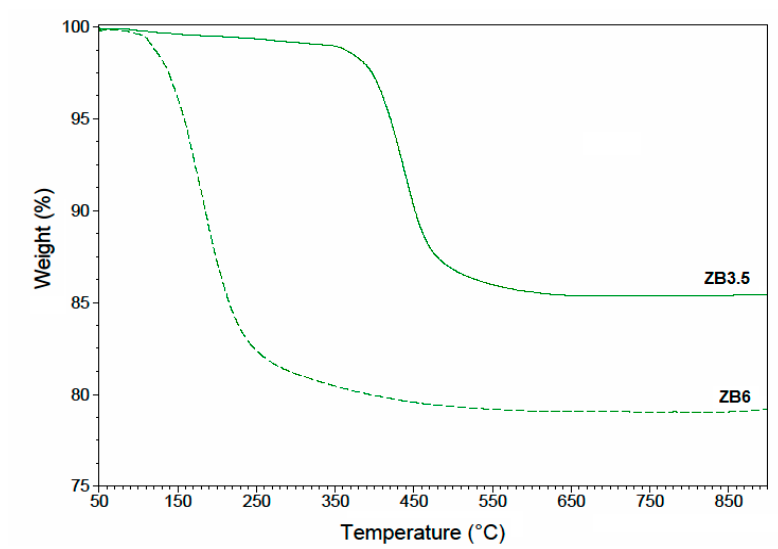
Figure 5. Thermogravimetric curves for the hydrated zinc borates.